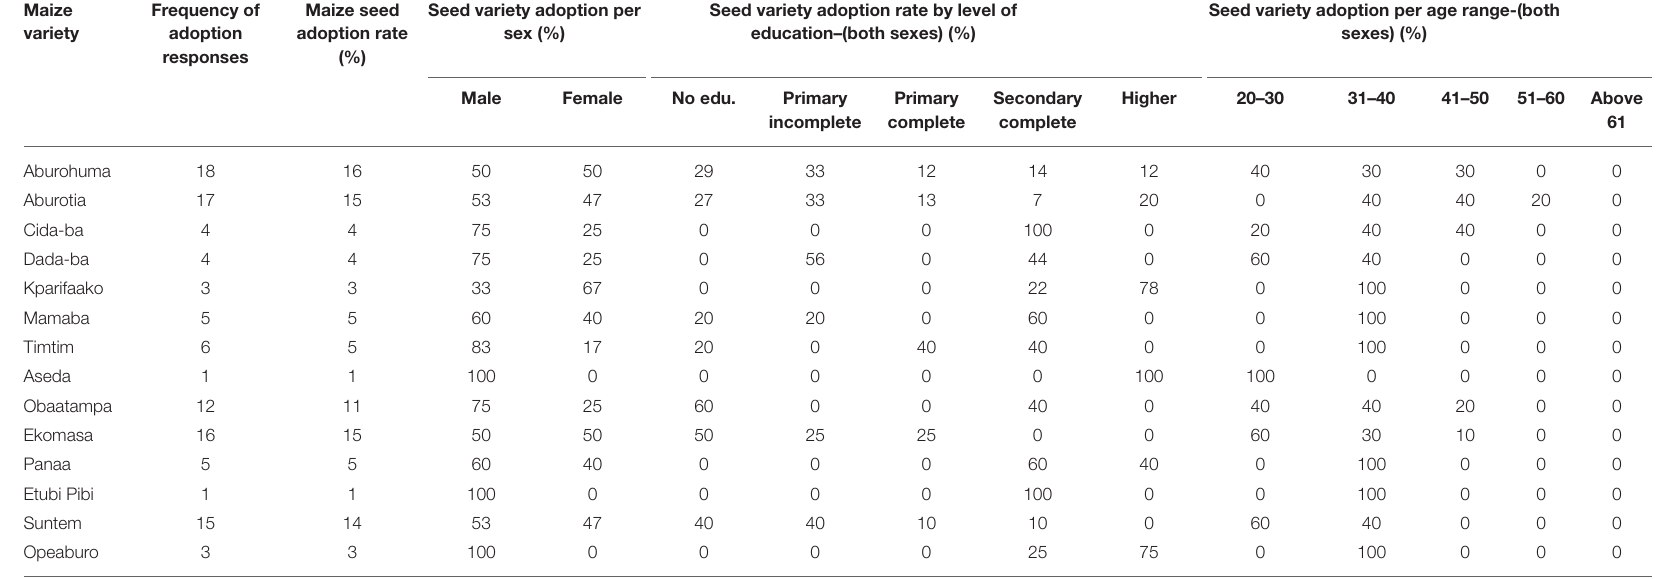
TABLE 4 | Distribution of maize variety adopted by smallholder farmers. Maize